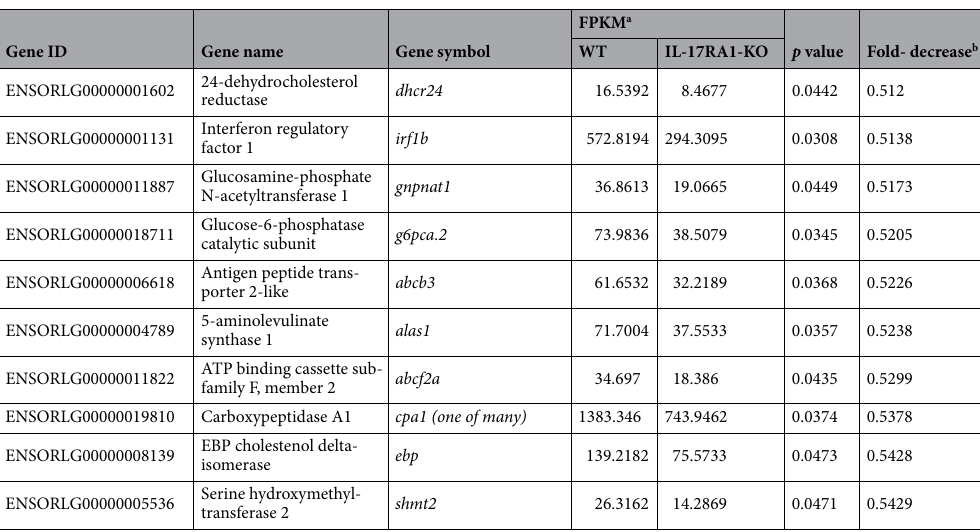
Table 1. Differentially expressed genes (DEG) down-regulated in the anterior intestine of IL-17RA1-KO medaka and their interactions with IL-17RA, based on String App software. a Fragment per kilobase of exon length per million reads. b Fold-decrease in the anterior intestine of IL-17RA1-KO, compared to that in WT